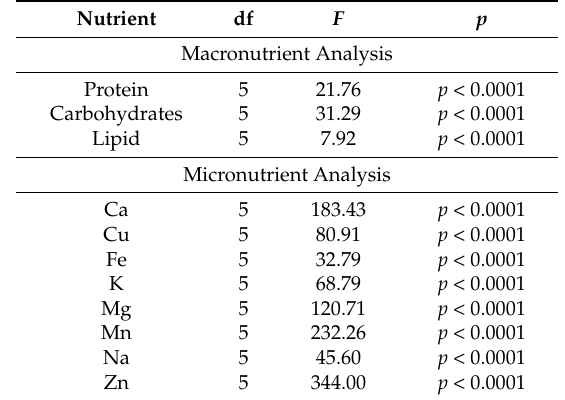
Table 1. Results for each nutrient from the MANOVAs for macro- and micronutrients for larvae and pupae of Trypoxylon